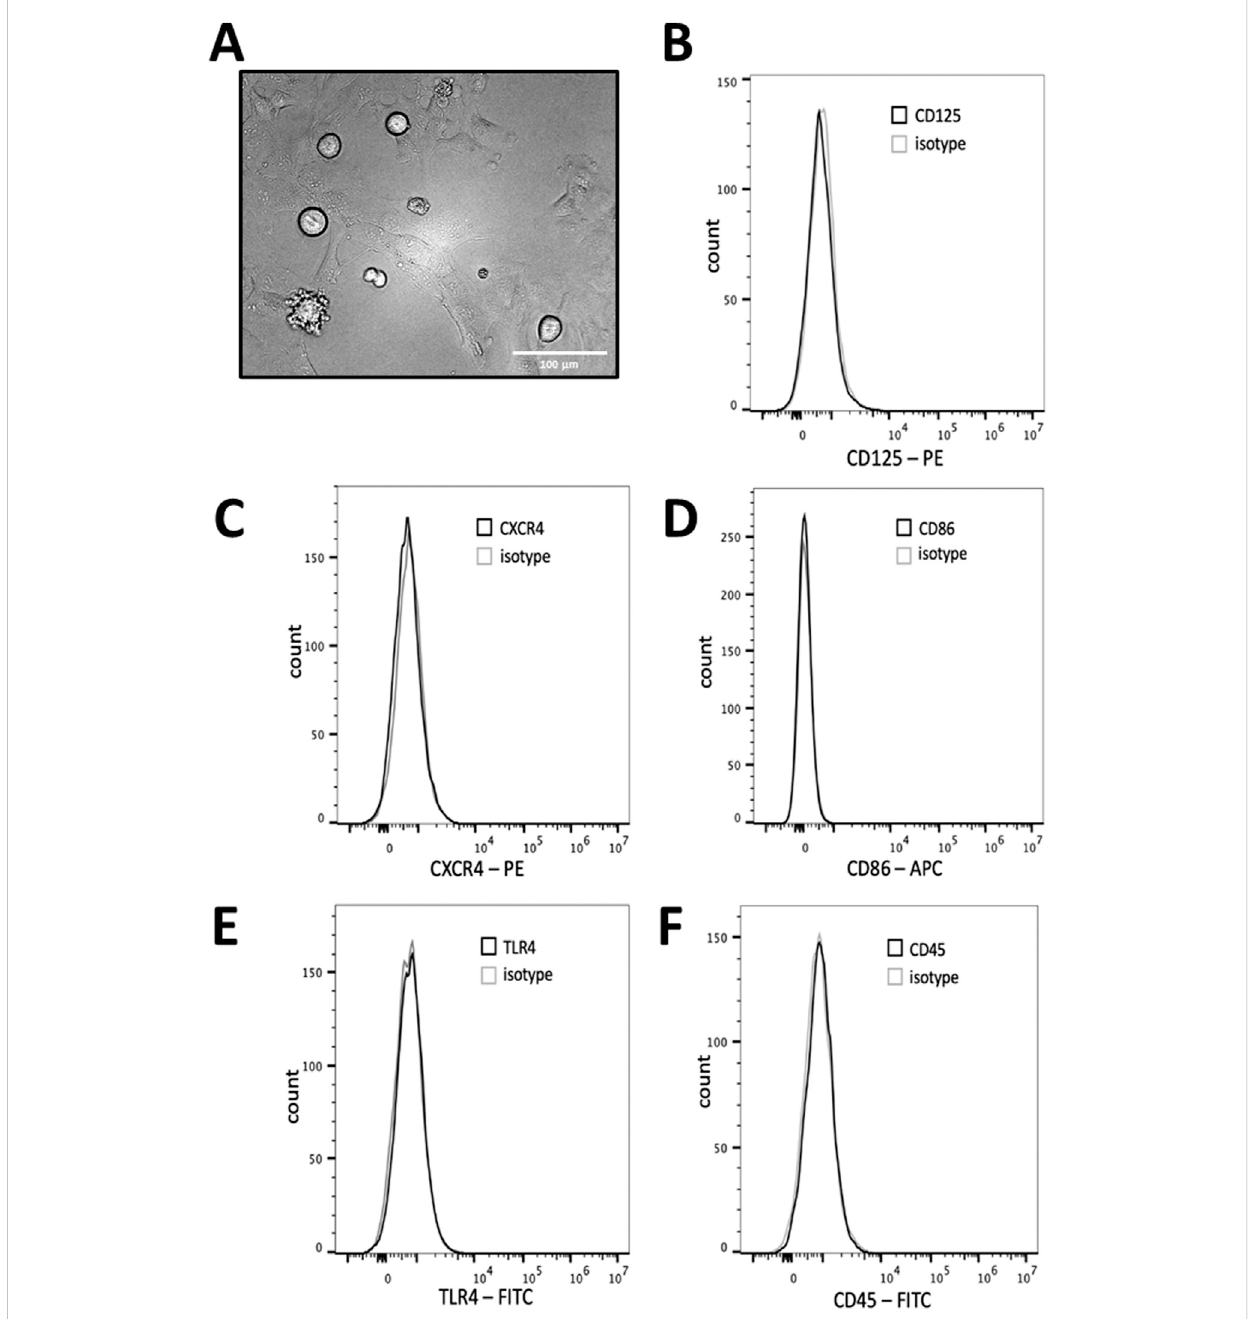
FIGURE 1 HMC3 cell morphology and biomarker expression. (A) HMC3 imaged via phase contrast microscopy at ×20 magni fi cation. HMC3 were plated and left, unstimulated, for 24 h and analyzed for expression of (B) CD125, (C) CXCR4, (D) CD86, (E) TLR4, or (F) CD45 and analyzed via fl ow cytometry. Data shown is representative of three independent experiments ( n =